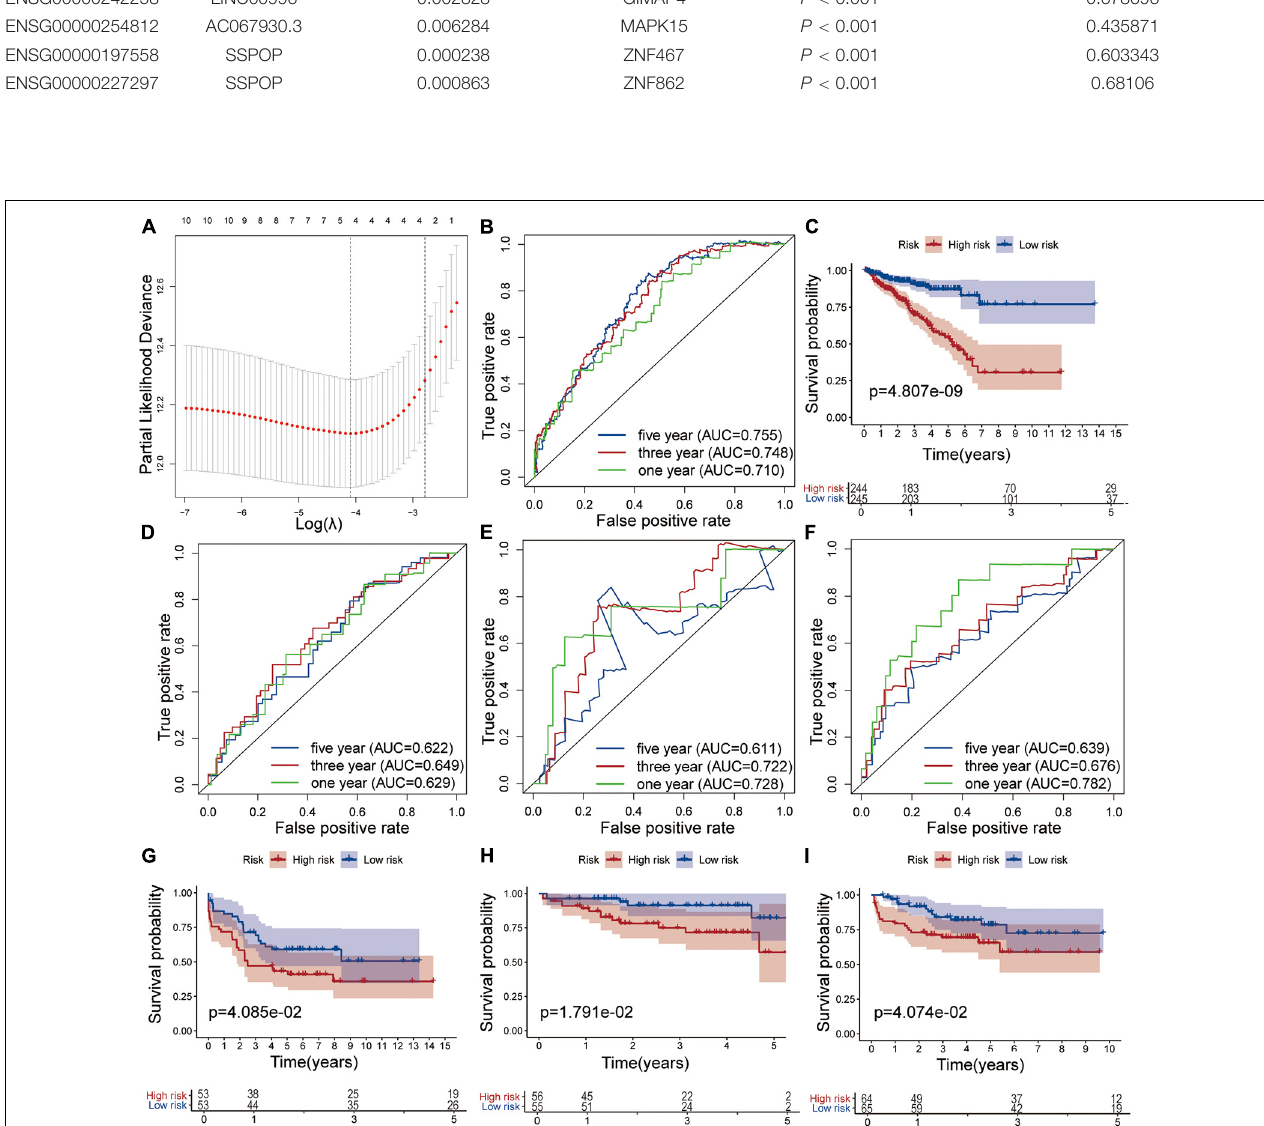
Frontiers in Genetics |